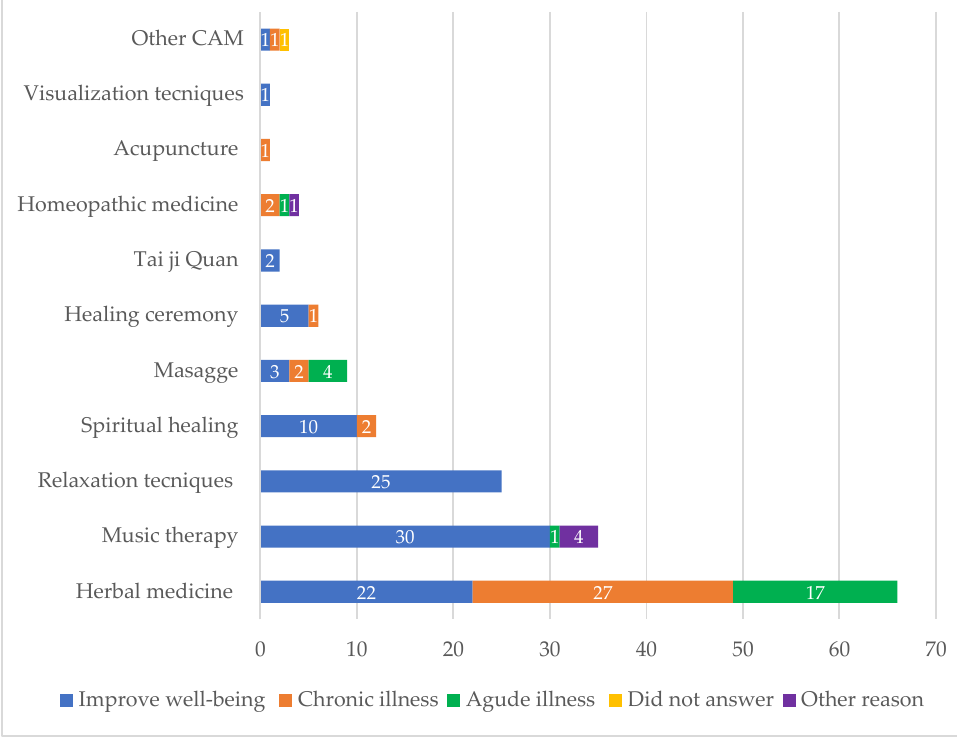
Table 3. Herbal medicine employed by patients.